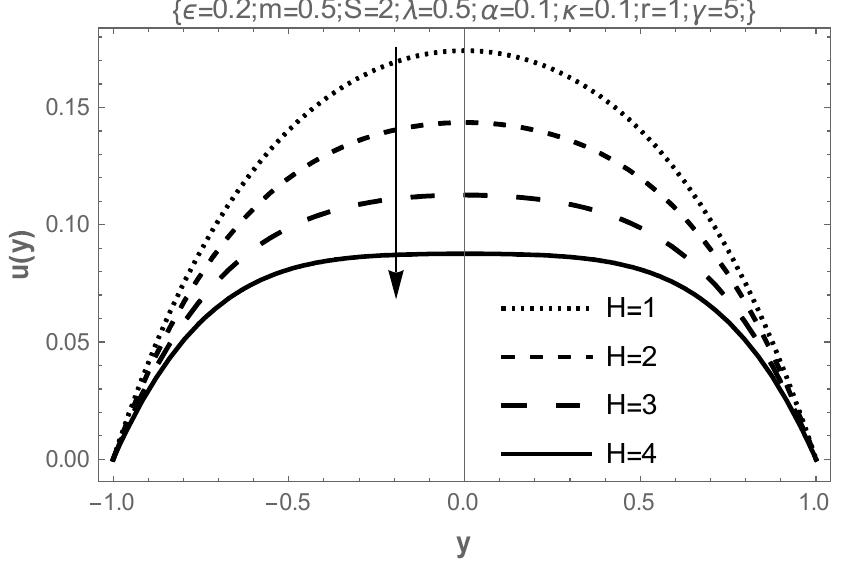
Figure 10. Effect of Hartmann number on flow velocity.